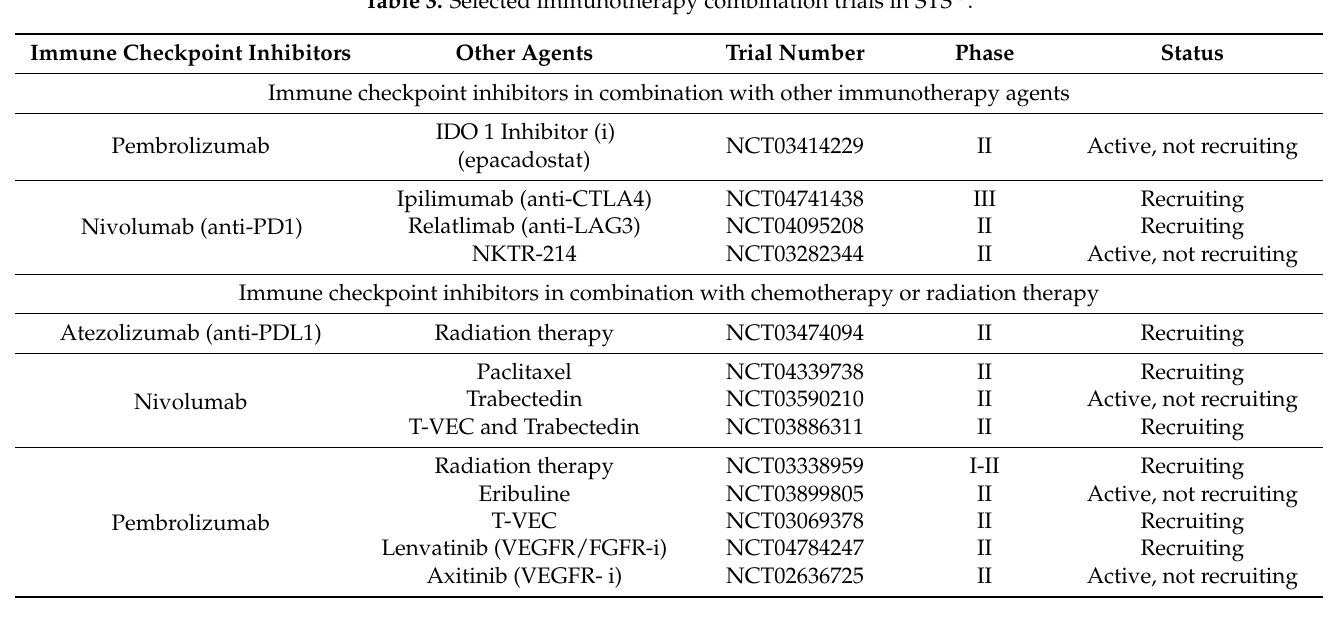
Table 3. Selected immunotherapy combination trials in STS a